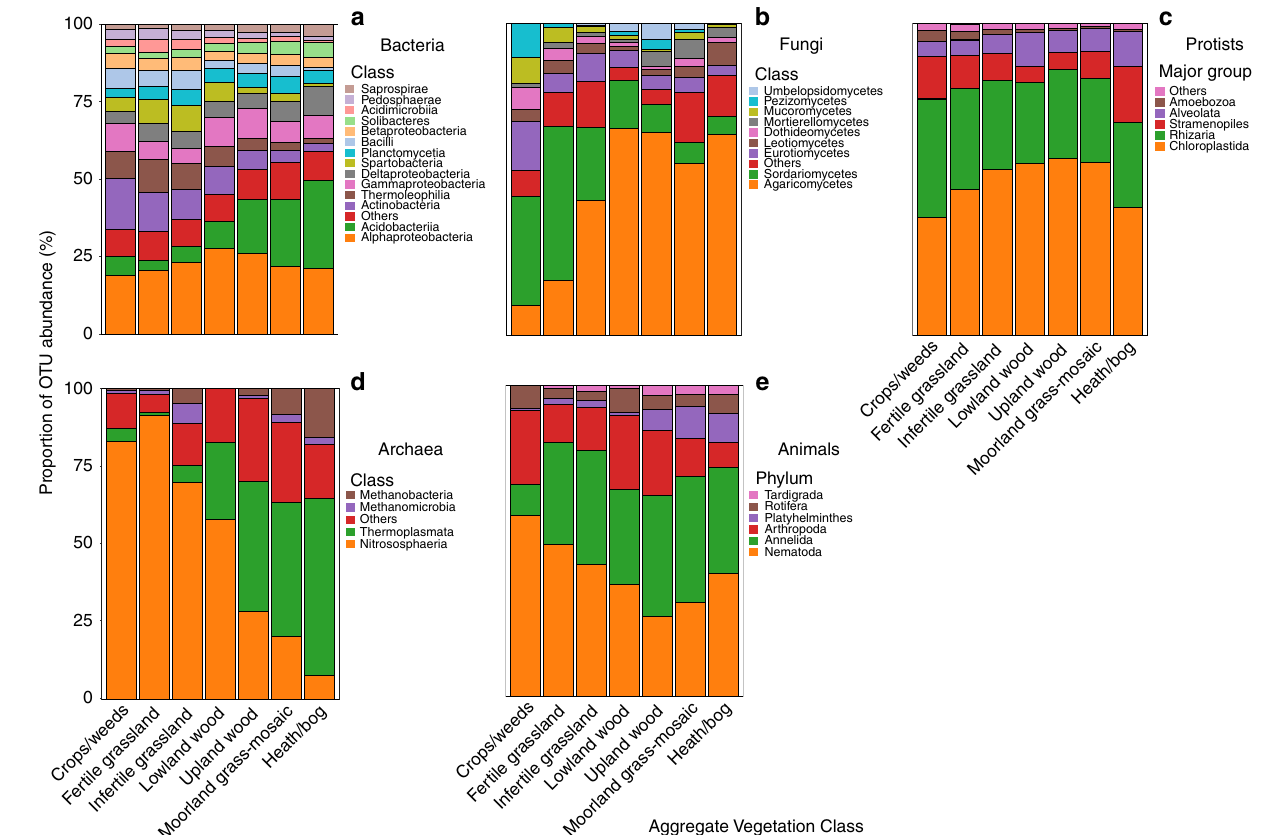
Fig. 2 Proportionate abundances of OTUs for major soil biota groups within each Aggregate Vegetation Class. Land uses are ordered from most (crops/ weeds) to least (heath/bog) using the same divisions as Fig. 1 for a bacteria; b fungi; c protists; d archaea; and e